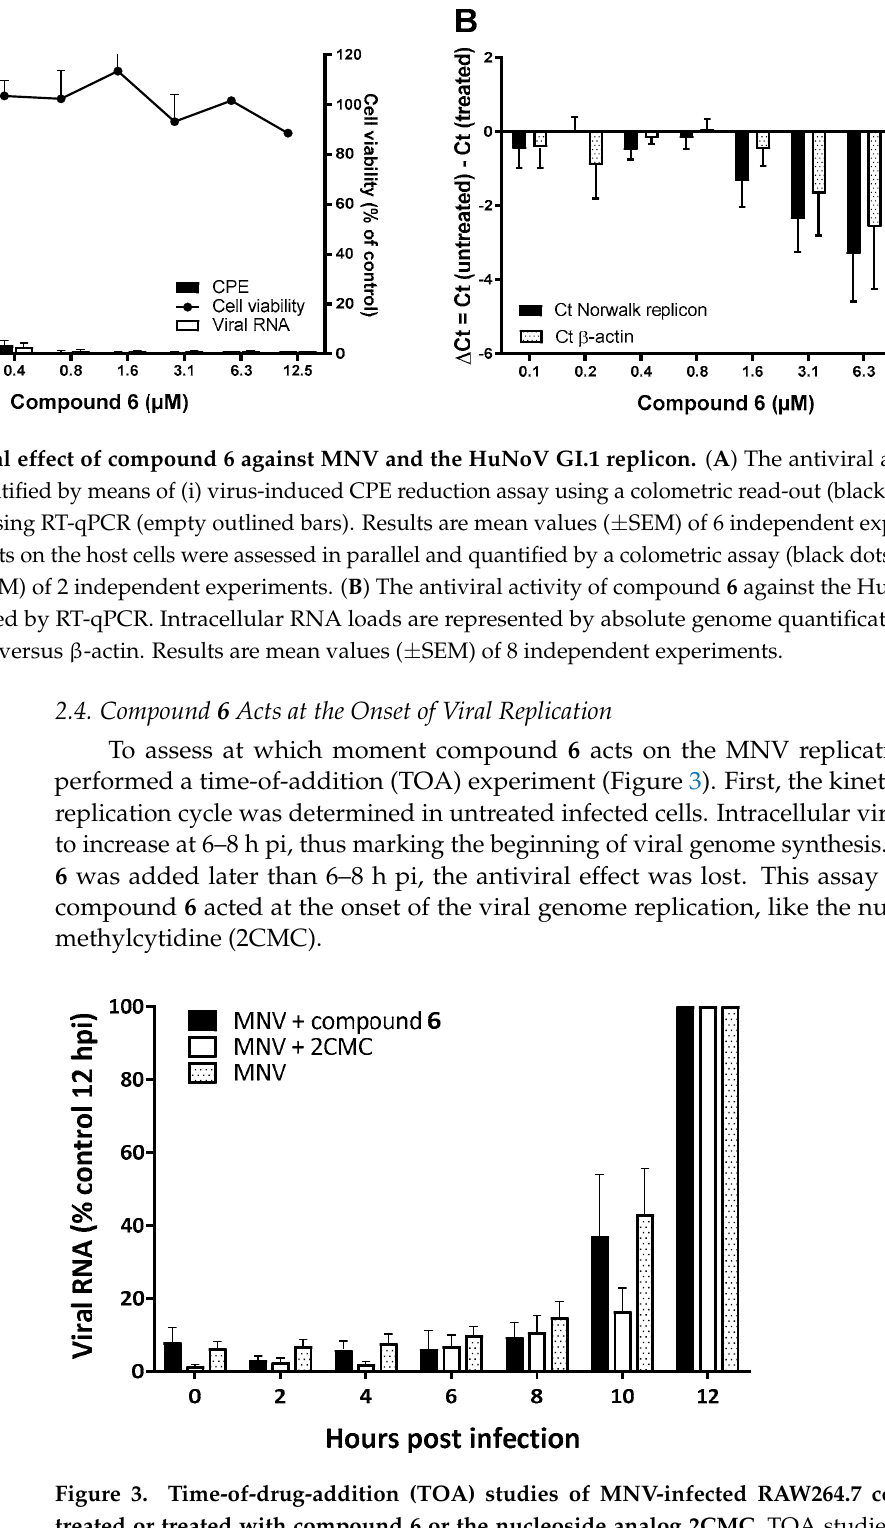
Figure 3. Time ‐ of ‐ drug ‐ addition (TOA) studies of MNV ‐ infected RAW264.7 cells, either un ‐ treated or treated with compound 6 or the nucleoside analog 2CMC. TOA studies of RAW264.7 cells infected and untreated (dotted bar) and RAW264.7 cells infected and treated with compound 6 (black bars) or 2CMC (empty outlined bars). Results are mean values (±SEM) of 3 independent experiments. 2.5. Compound 6 Does Not Directly Inhibit the Norovirus Polymerase Given that compound 6 acts at the same time point in the viral replication cycle as polymerase inhibitors, we could assume that the compound inhibits the active site of the MNV polymerase by directly competing with their natural substrate, as a nucleoside an ‐ alog would. However, no direct competition between the norovirus polymerase and the natural substrate was observed when the compound was present.